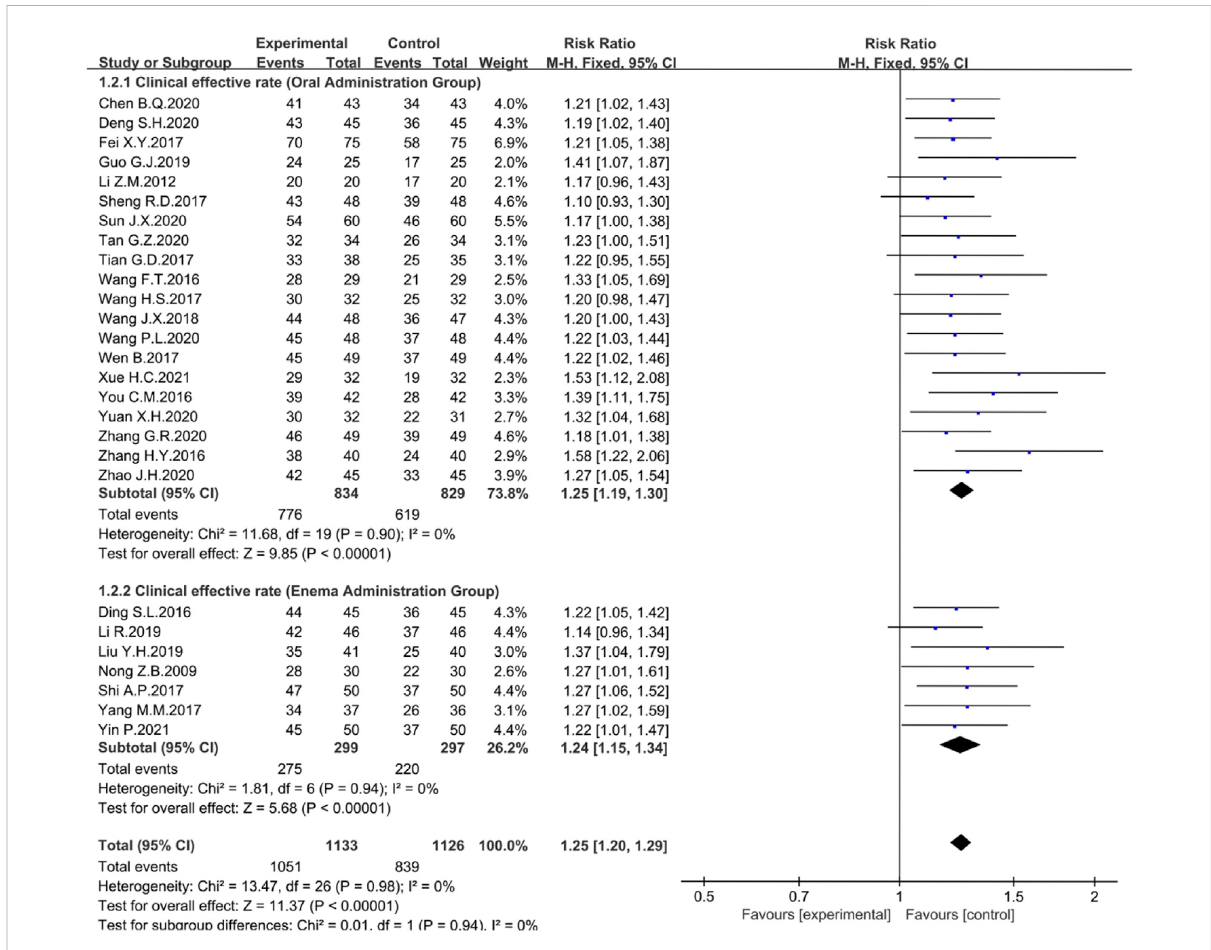
FIGURE 5 Forest plot displaying the results of the Meta-analysis for clinical ef fi ciency in different dosing